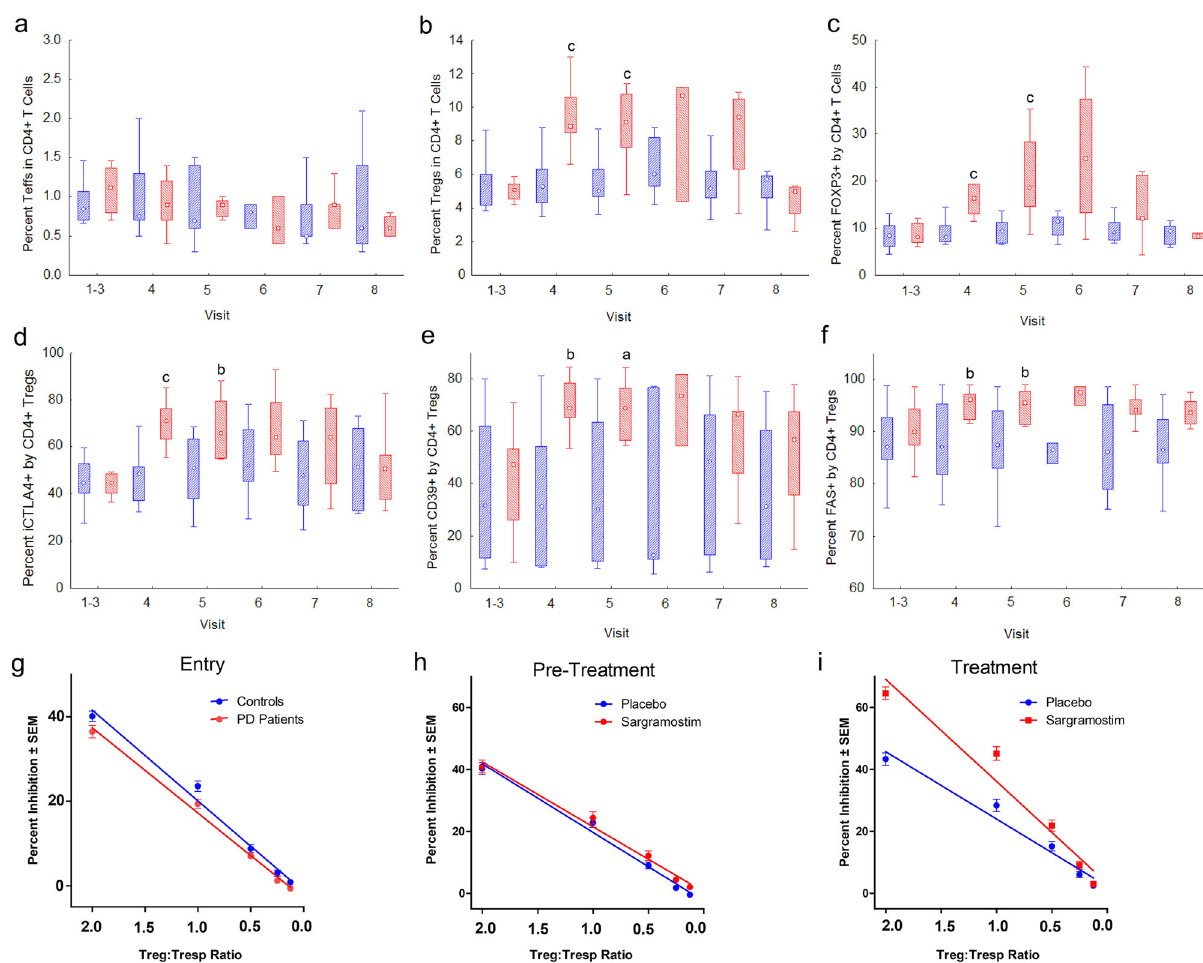
Fig. 1 Peripheral blood lymphocytes from PD patients treated with placebo or sargramostim were assessed for the expression of Treg phenotype and function over a 3-month mean baseline (visits 1 – 3), every 2 weeks after the initiation of treatment (visits 4 – 7), and 4 weeks after discontinuation of treatment (visit 8). Flow cytometric analyses for percentage of a CD4+ Teffs (CD4+CD127hiCD25hi), b CD4+ Tregs (CD4+CD127loCD25hi), c FOXP3+CD4+ Tregs, d iCTLA4+CD4+ Tregs, e CD39+CD4+ Tregs, and f FAS+CD4+ Tregs. Plots represent the medians, interquartile ranges (IQRs) ( boxes ), and non-outlier ranges ( whiskers ) for T cells from PD patients. Levels of T cell subsets from PD patients treated with placebo ( n = 6 – 10) ( blue ) or sargramostim ( n = 5 – 9) ( red ) were compared by Mann – Whitney U test with P ≤ a 0.10, b 0.05, or c